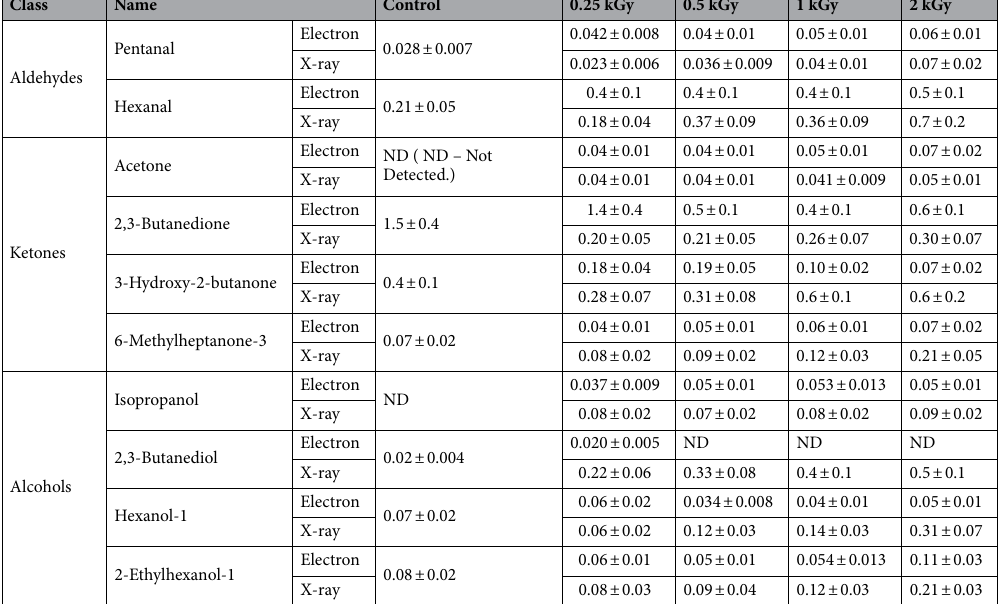
in the studied samples as well as their amount in mg/kg irradiated with X-rays and electrons for various doses. Chilled turkey meat contains water, fats, proteins, amino acids, and vitamins, among other compounds. When the water fraction is exposed to ionizing radiation, free radicals are formed in it, which, in the presence of oxy- gen, initiate various oxidation reactions of organic molecules. Lipids, which contain saturated and unsaturated fatty acids, whose share in meat products is quite large, are the main target of oxidative processes for doses up to 1–2 kGy 33–36 . Fatty acids break down into alcohols, which, in turn, break down into aldehydes and ketones. storage, and their intensity is a function of the temperature, concentration of oxygen, water, etc. After exposure to ionizing radiation, the intensity of the reactions of accumulation and decay of volatile compounds increases. Various dependencies of alcohols (which are products of fatty acid decay) from the absorbed dose were identi- fied for electron and X-ray irradiation. A similar dependence of the concentration from the dose of radiation in both types of radiation was identified for isopropanol, and it can be described as a function f(D) :